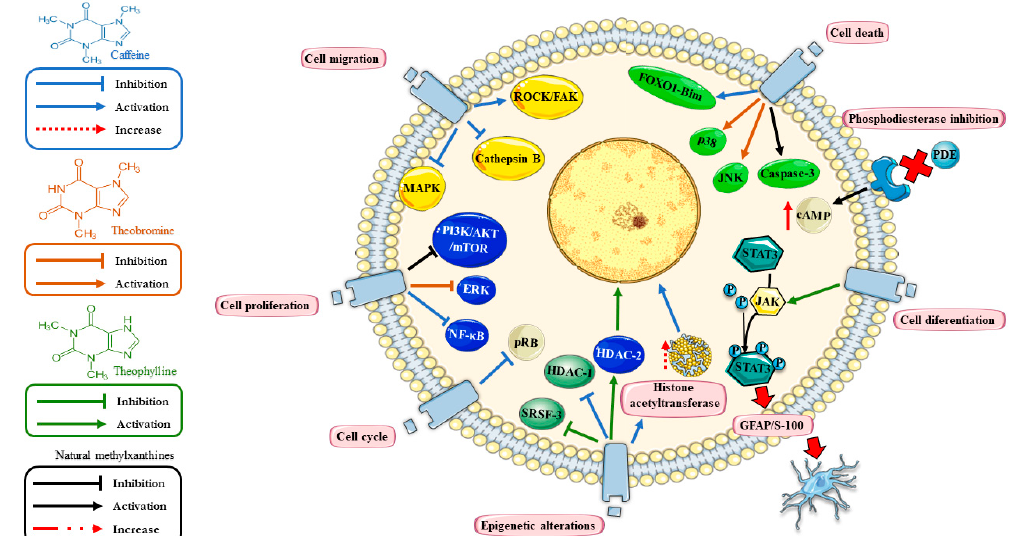
Figure 1. Mechanisms of action of methylxanthine (MTXs) in glioblastoma (GBM). The figure shows common pathways regulated by MTXs (black arrows) including inhibition of phosphodiesterases (PDEs) (reducing the levels of cyclic Adenosine Monophosphate (cAMP)); regulation of cell proliferation (PI3K/AKT-mTOR); and cell death (caspase 3). Particularly, caffeine (blue arrows) promotes cell death (FOXO1-Bim); cell migration (by these proteins ROCK/FAK pathway, MAPK and cathepsin B); cell proliferation (NF-kB); cell cycle (pRB) and epigenetic mechanisms (HAT ‒ histone acetyltransferases and HDAC-1). Theobromine (orange arrow) regulates cell proliferation (ERK) and apoptosis (JNK and p38). Theophylline (green arrow) regulates cell differentiation (JAK/STAT3 pathway), the epigenetic mechanism (HDAC-2) and alternative splicing (SRSF3). The figure was designed using Servier Medical Art ©. Table 1. Effect of methylxanthines in glioma.